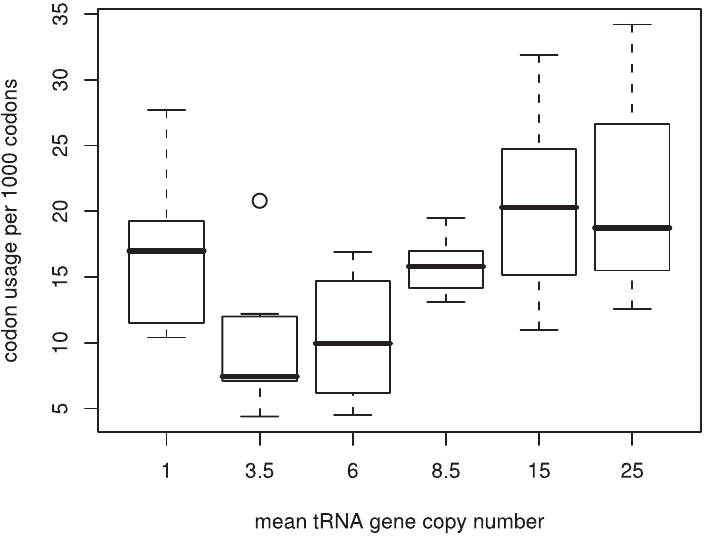
Figure 1. Correlation between tRNA gene copy number and genome codon usage. There is an overall trend for codons with high genome usage to have more cognate tRNA gene copies. However, the codons with the fewest cognate tRNA genes are not the most rare within the genome.